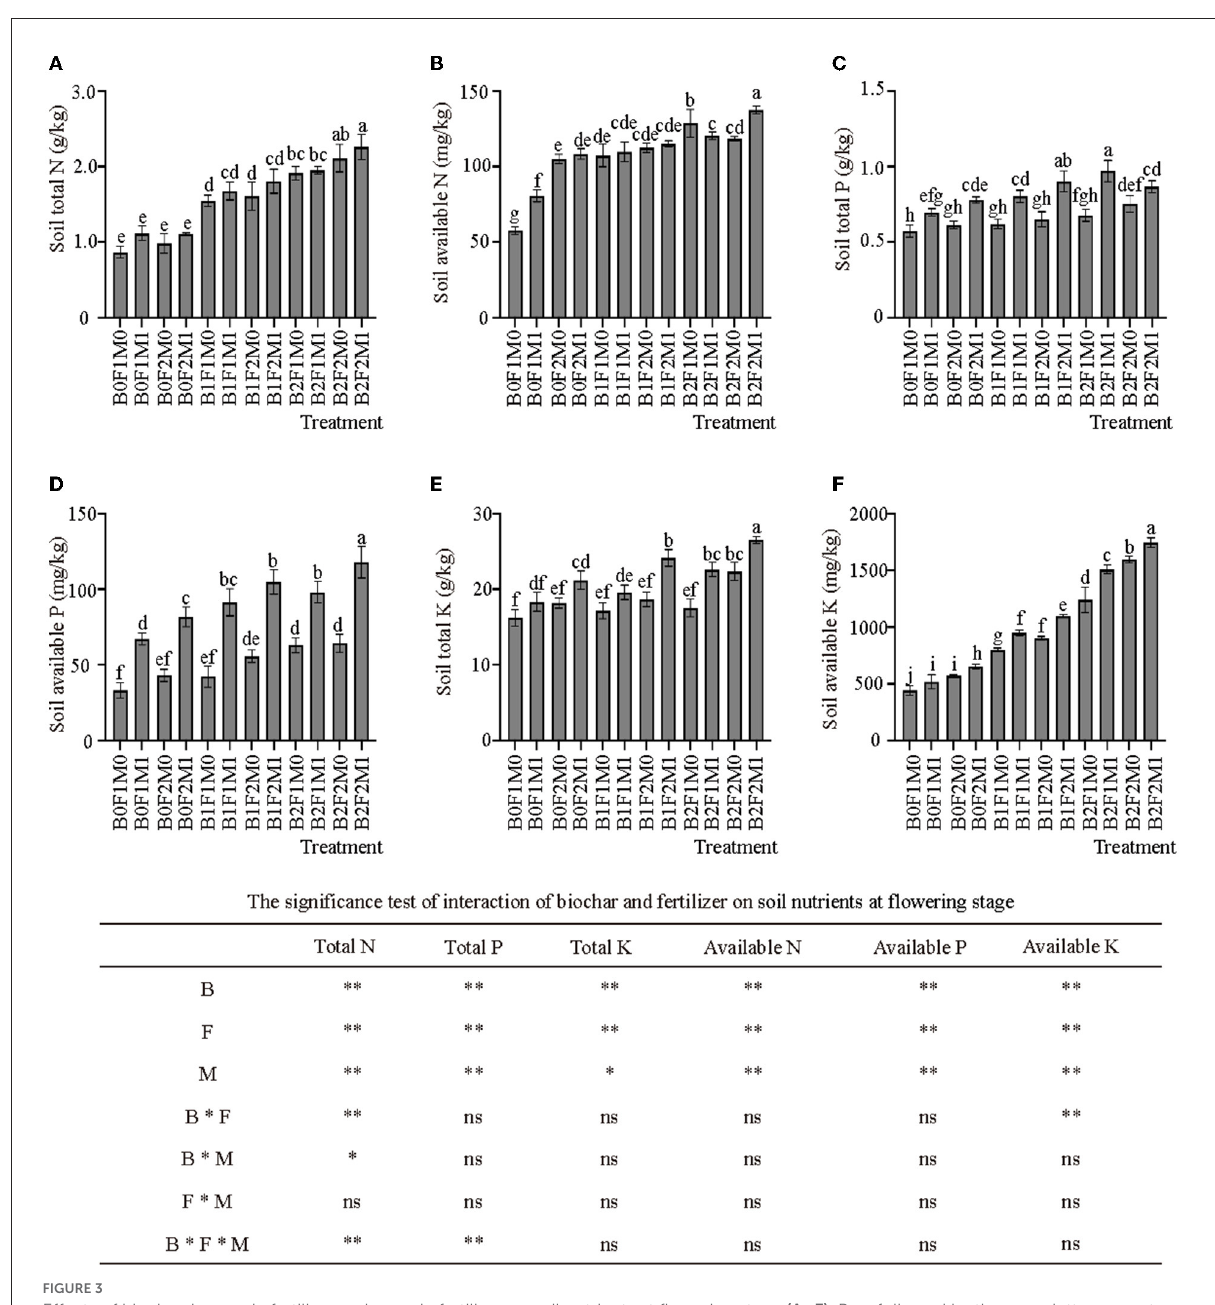
FIGURE3 Effects of biochar, inorganic fertilizer and organic fertilizer on soil nutrients at flowering stage (A–F) . Bars followed by the same letter are not significantly different according to LSD-test ( P ≤ 0.05). Bars represent standard errors of the means. * and ** Significant difference at p = 0.05 and p = 0.01, respectively, and ns indicates no significant